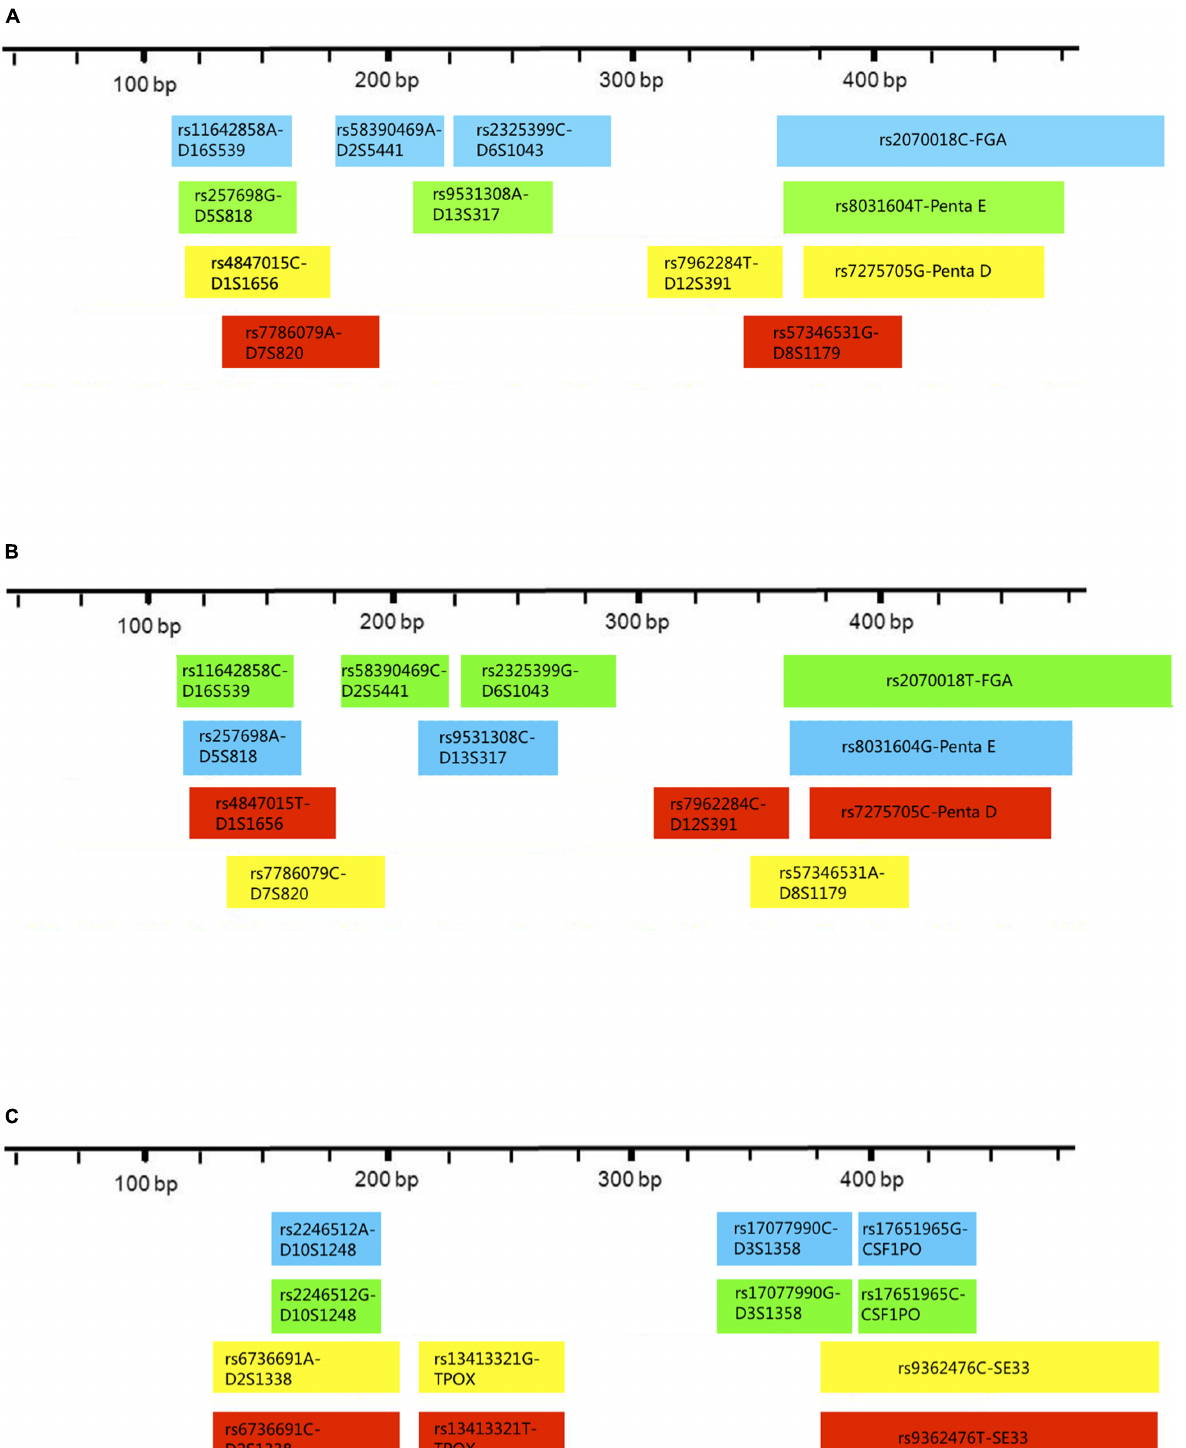
Frontiers in Genetics |